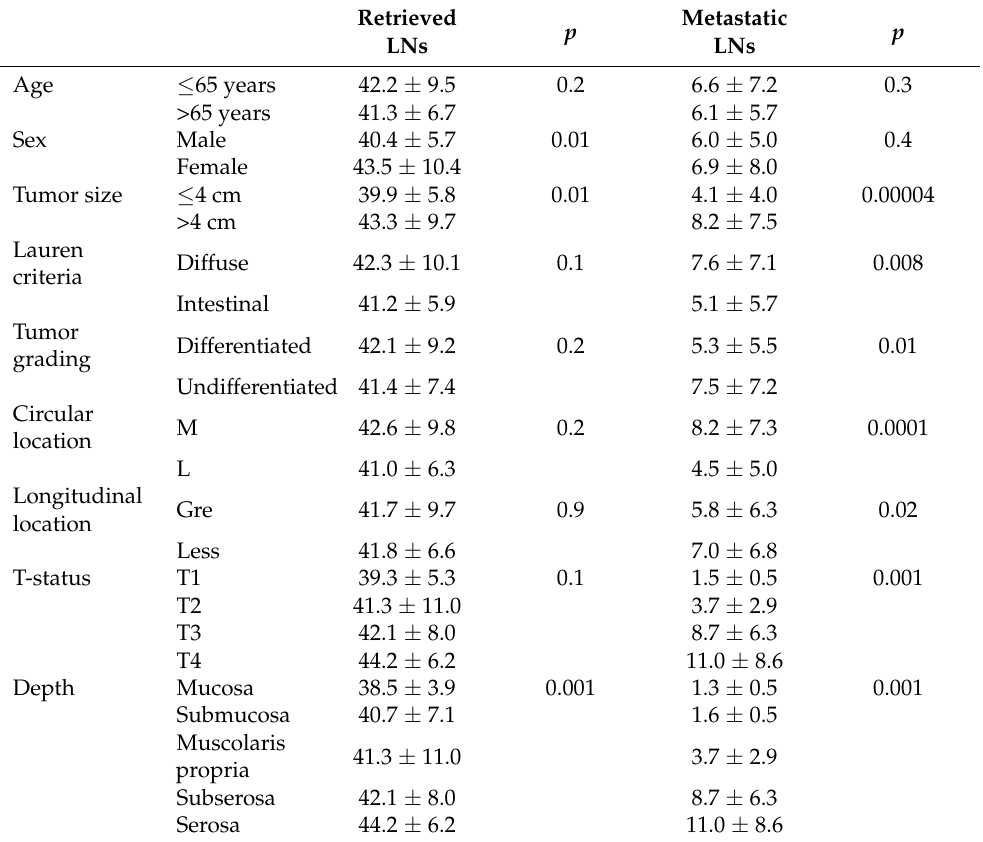
Table 3. Number of retrieved LNs and number of metastatic LNs, in relation to the clinical, anatomical and pathological parameters